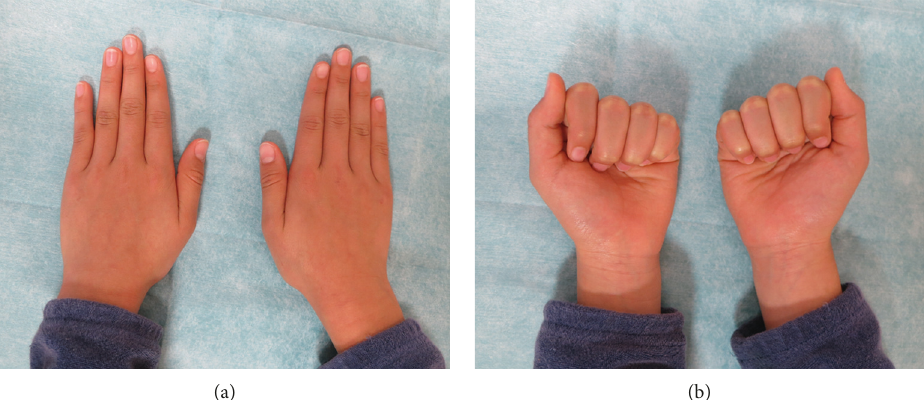
Figure 6: Preoperative photographs of Case 2. (a) There was a gap between the left ring and little fingers in the fully extended and adducted position. (b) The left little finger was partially covered by the ring finger in the fully flexed position.